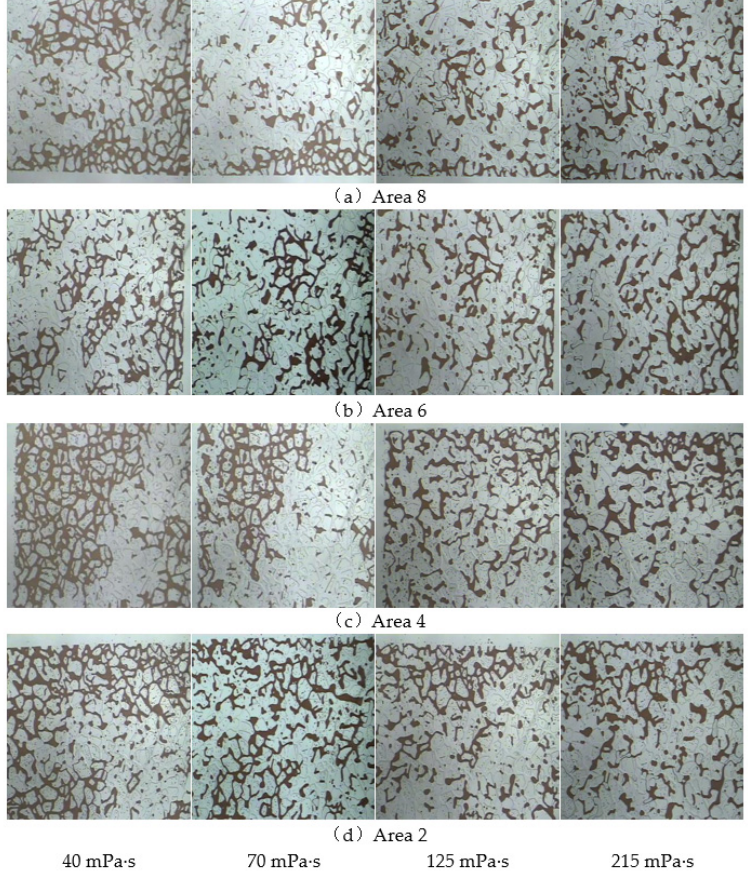
Figure 13. Microscopic remaining oil production in the shunt line area under different viscosity conditions. ( a ) Area 8. ( b ) Area 6. ( c ) Area 4. ( d ) Area 2.